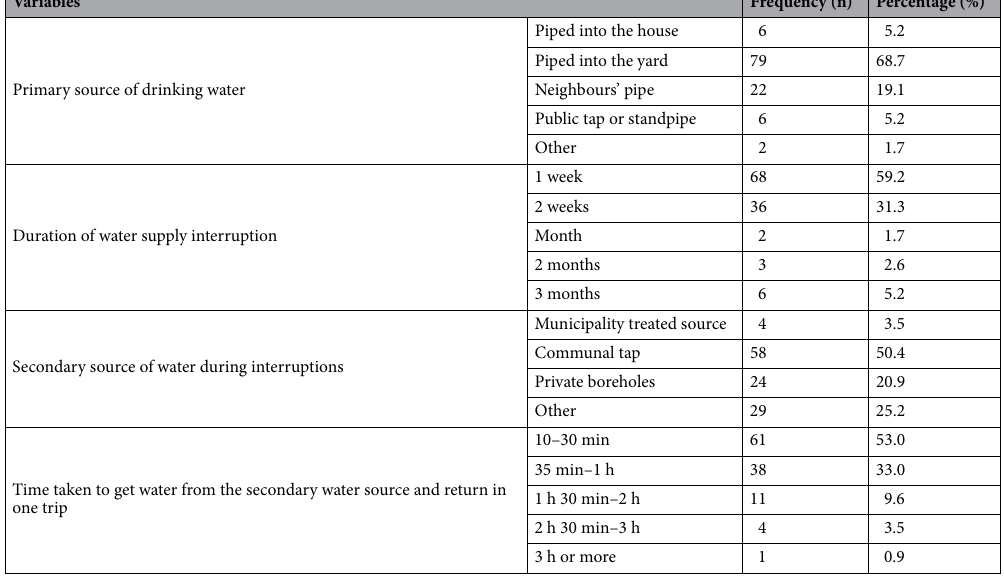
Table 2. Water supply in the household.